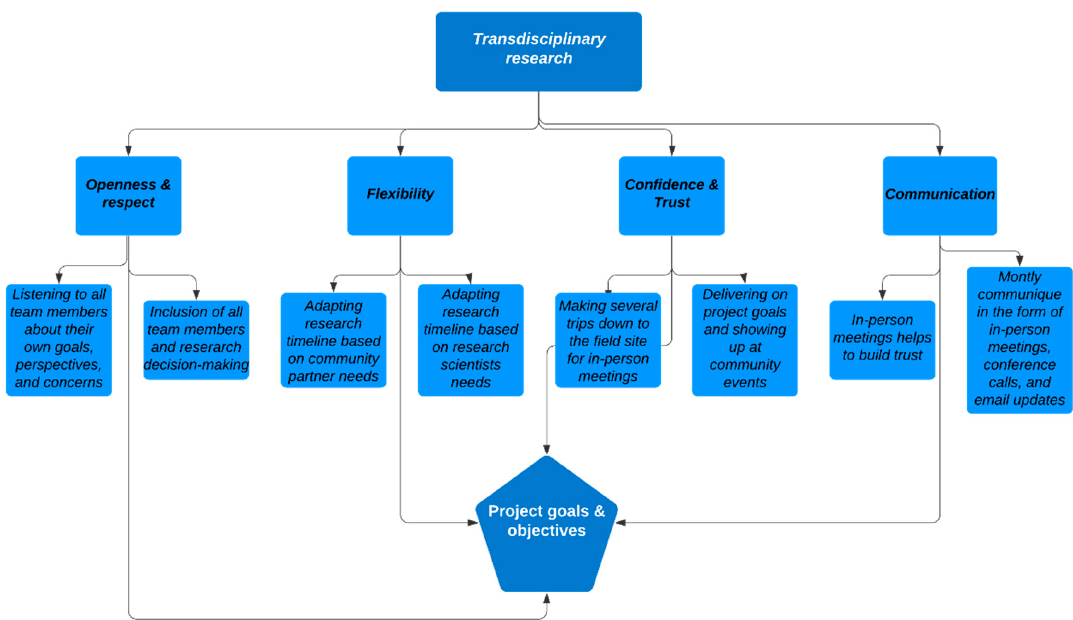
Figure A1. A flowchart for doing transdisciplinary research. These key elements must be developed and sustained throughout the research